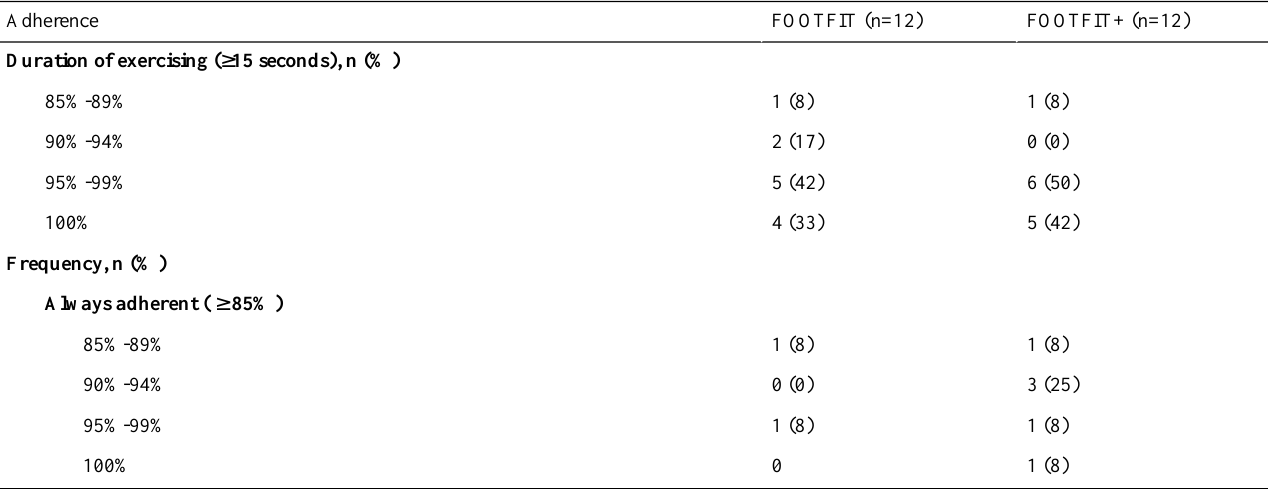
Table 2. Distribution of adherence level to recommended exercise duration by FOOTFIT and FOOTFIT+ groups (N=24).